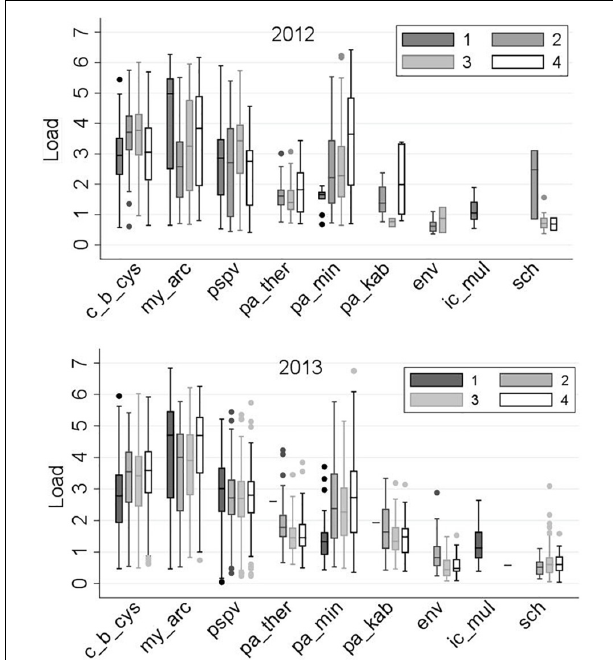
FIGURE 6 | Distribution of the loads [log 10 (copy number + 1)] of the nine common infectious agents (as described in Table 1 ) in 2,006 Fraser River juvenile Sockeye salmon by sampling region and year. Sampling regions: (1) Freshwater, (2) Strait of Georgia, (3) Discovery Islands, and (4) Johnstone Strait and